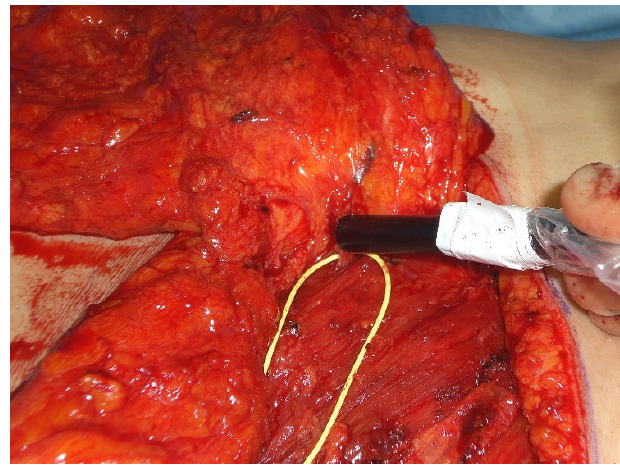
Figure 3. Preparation of the IMAP and evaluating its flow with a handheld Doppler.